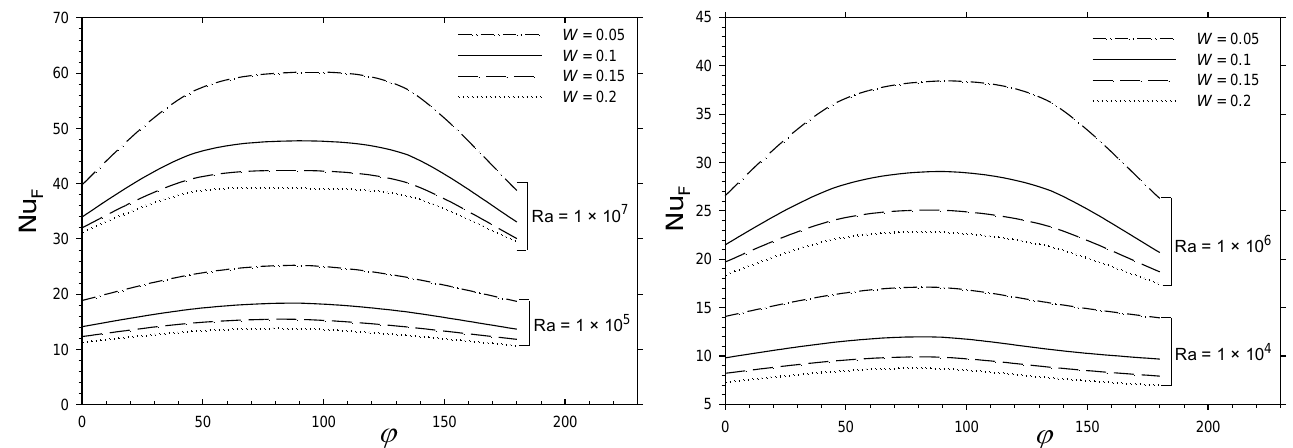
Figure 15. Variations in mean Nusselt number for the front of a slender cuboid with inclination ϕ for different Ra and W